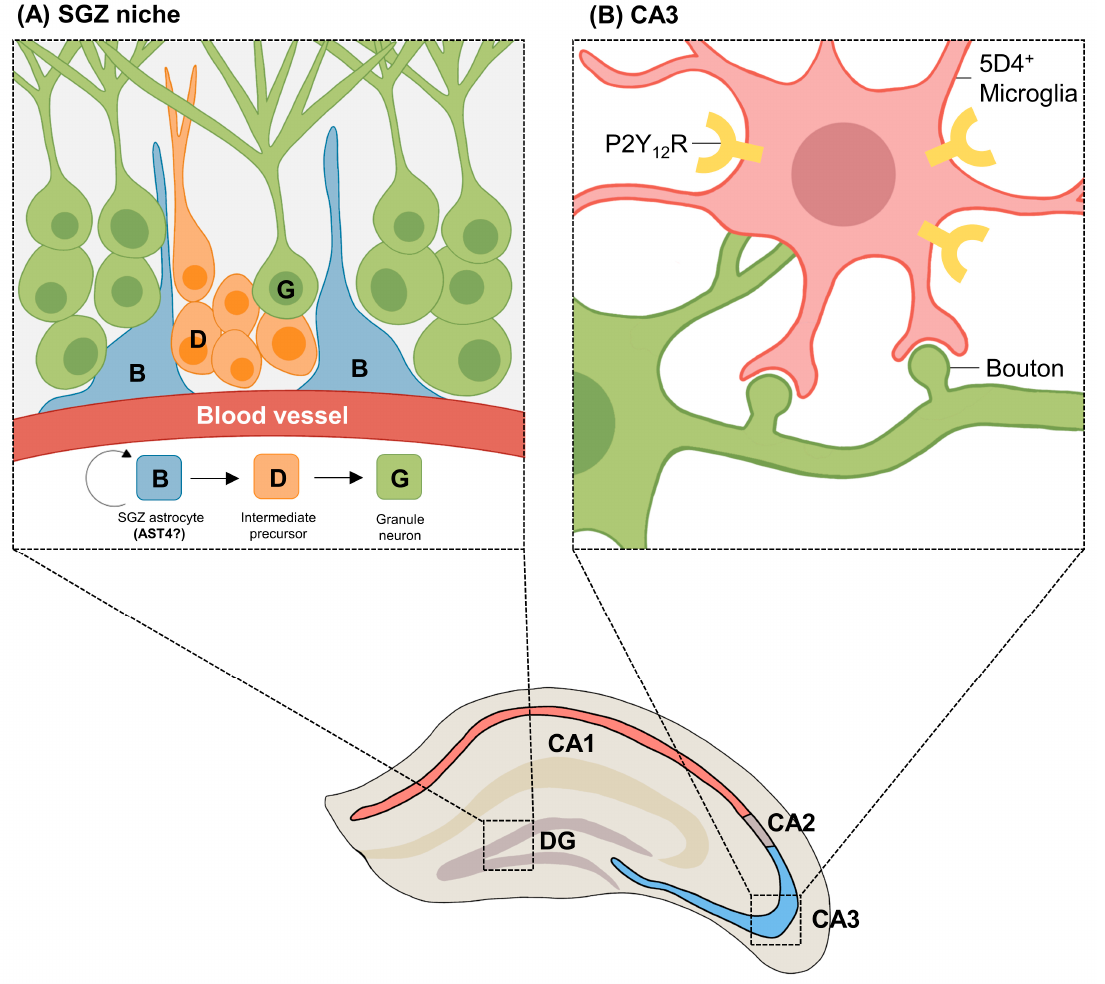
Figure 2. An example of hippocampus-specific astrocytes and microglia. ( A ) Adult neurogenesis in subgranular zone (SGZ) of hippocampal dentate gyrus (DG) is initiated when self-proliferate SGZ astrocyte (B, blue) divides into intermediate precursor cell (D, orange), which further differentiates into granule neurons (G, green). Batiuk et al. (2020) recently found that a specific subtype of astrocyte (AST4), which highly expressed genes associated with adult neurogenesis, was localized in SGZ. They hypothesized that AST4 may be the neural stem cell that participates in adult neurogenesis. ( B ) A specific subpopulation of microglia (pink) exists in CA3 region of hippocampus. 5D4 keratan sulfate epitope-positive (5D4 + ) microglia makes direct contacts with synaptic boutons of CA3 hippocampal neurons (green), thereby increasing the synaptic activity. CA3-specific 5D4 + microglia also highly express purinergic receptor P2Y 12 (P2Y 12 R), which is known to regulate synaptic plasticity. A genetic analysis using a recent single-cell RNA sequencing technique also